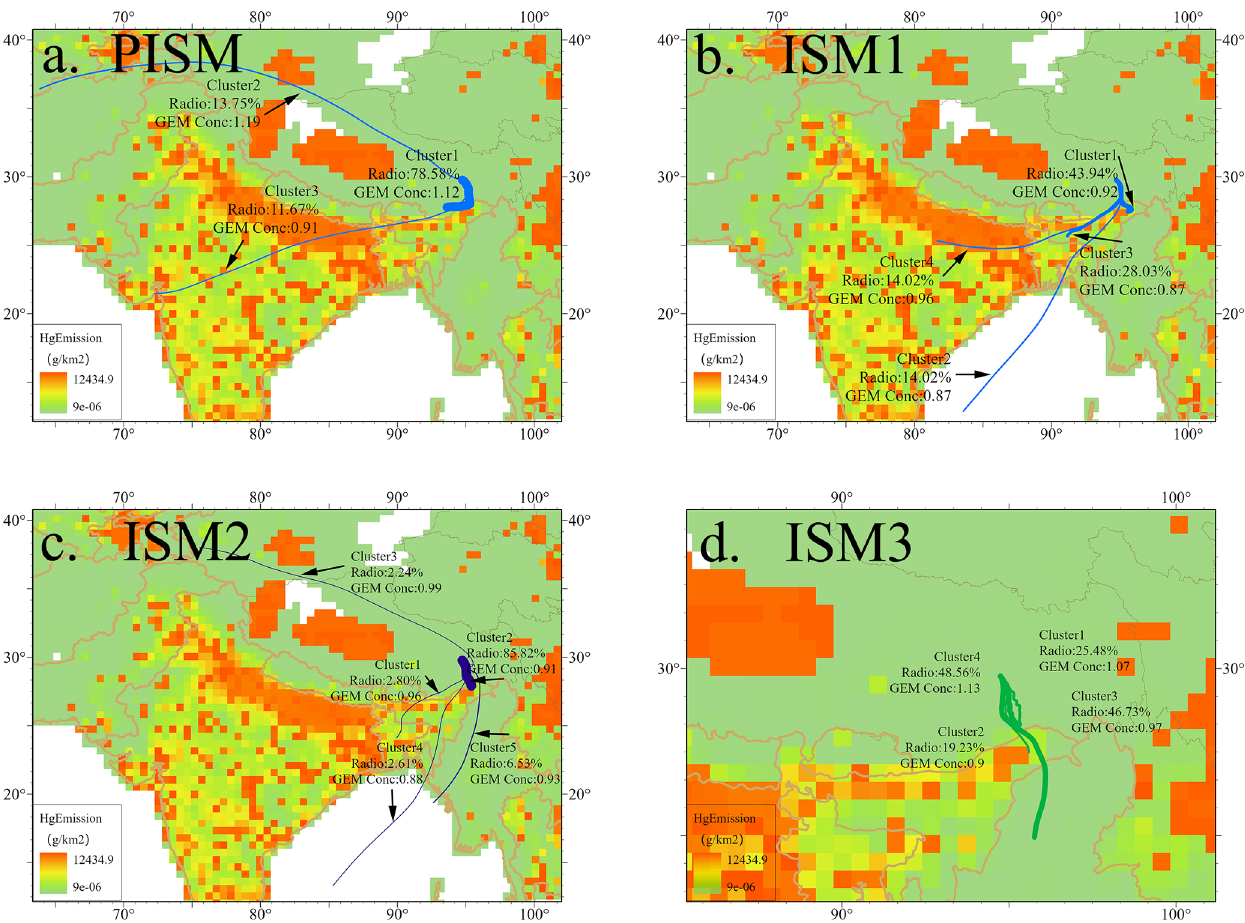
Figure 5. Clusters of the back trajectory analysis from SET site during PISM to ISM3 periods. The thickness of the line represents the ratio of the cluster in the time period, the background is the global Hg emission inventory developed by UNEP